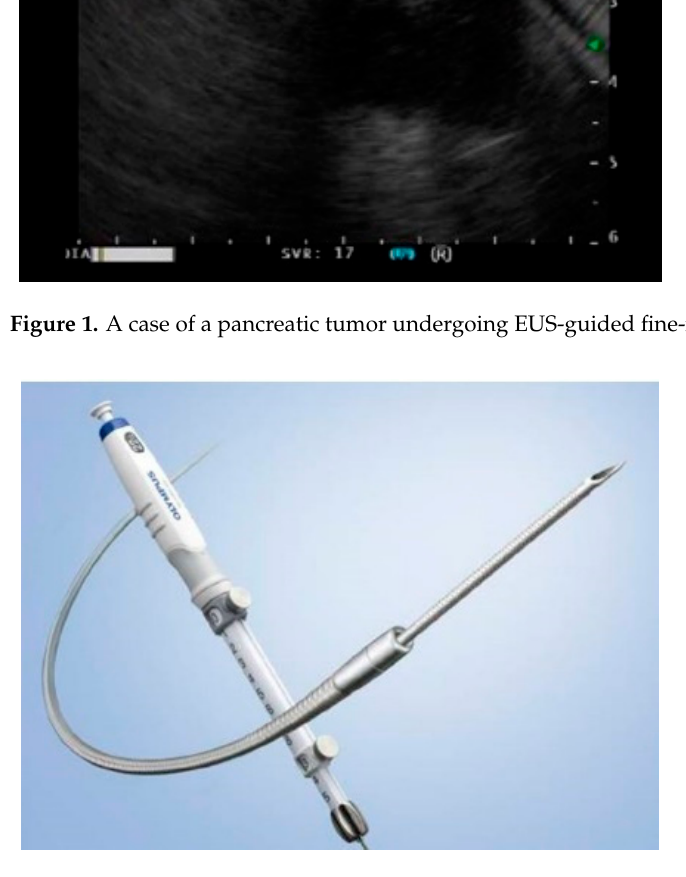
Figure 2. The EZshot3 plus (Olympus Medical Japan, Tokyo, Japan).